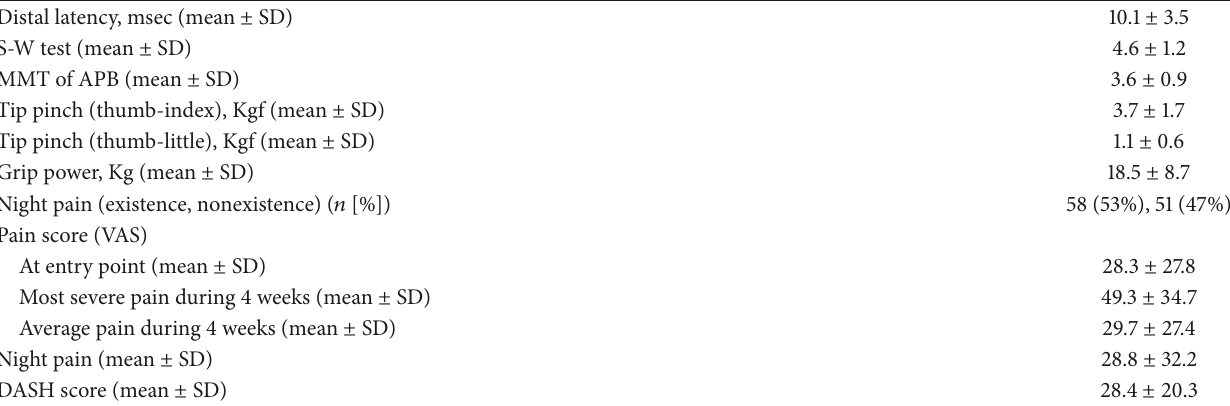
Table 2: Findings of the examination before surgery.